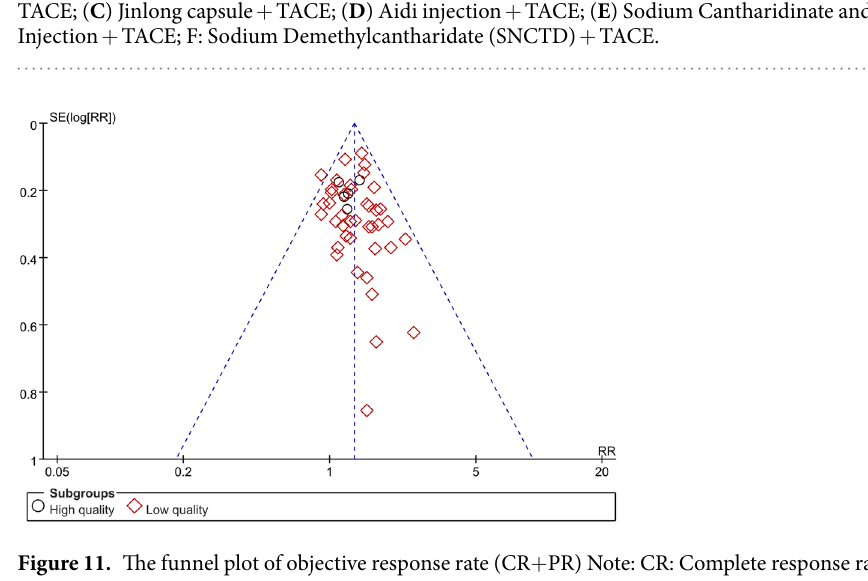
Figure 11. The funnel plot of objective response rate (CR + PR) Note: CR: Complete response rate. PR: Partial response rate.